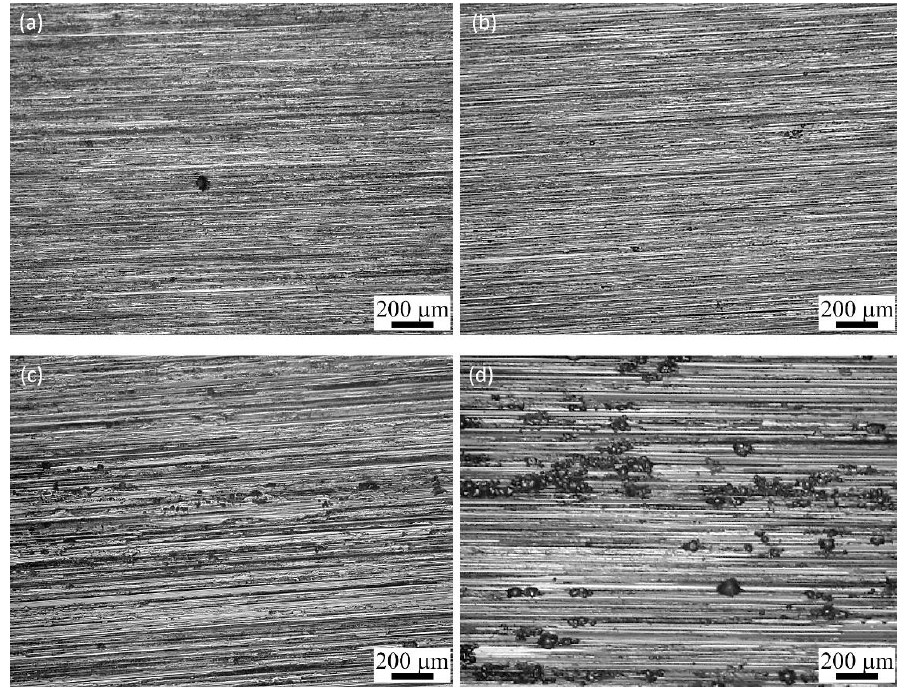
Figure 8. Surface optical images after 200 s of Galvanostatic testing in 3.5% sodium chloride aqueous solution for ( a ) annealed ( b ) 207 MPa ( c ) 310 MPa ( d ) 460 MPa.